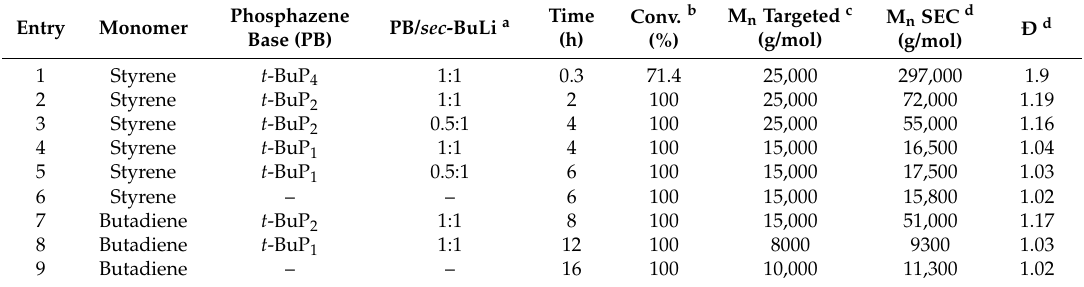
Table 1. Anionic polymerization of styrene and 1,3-butadiene in the presence of phosphazene